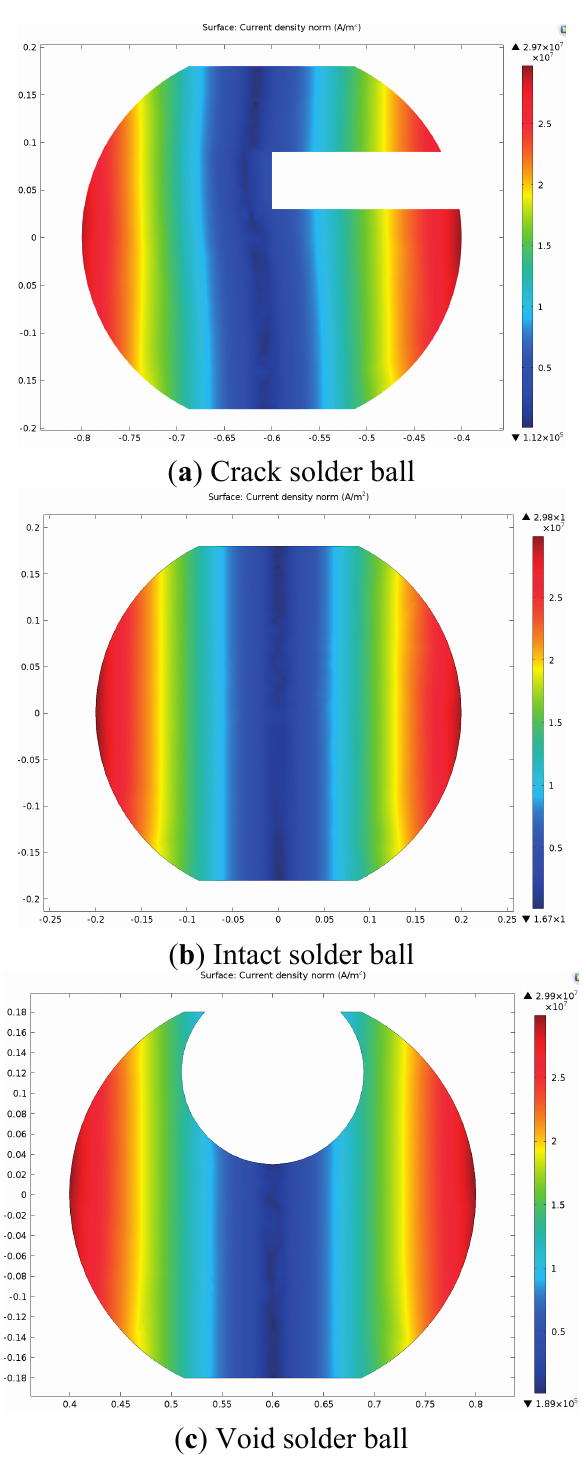
Figure 6. The eddy current density